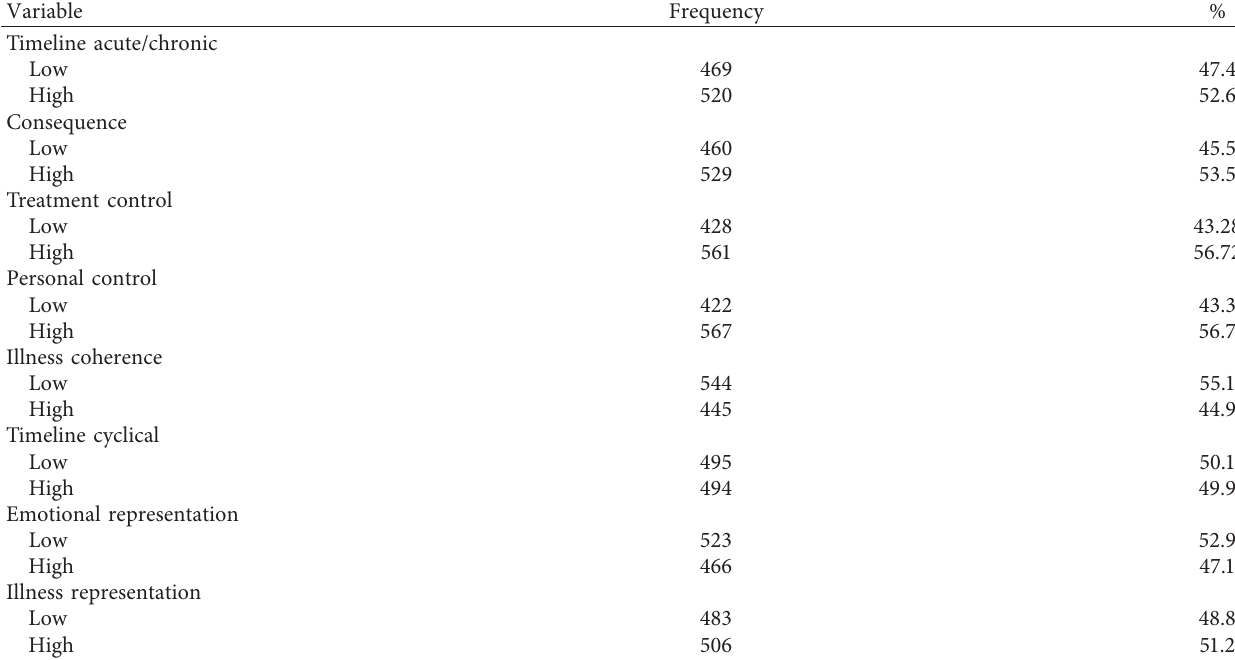
Table 4: Illness perception of hypertensive patients in Central Ethiopia, 2017 ( n � 989).